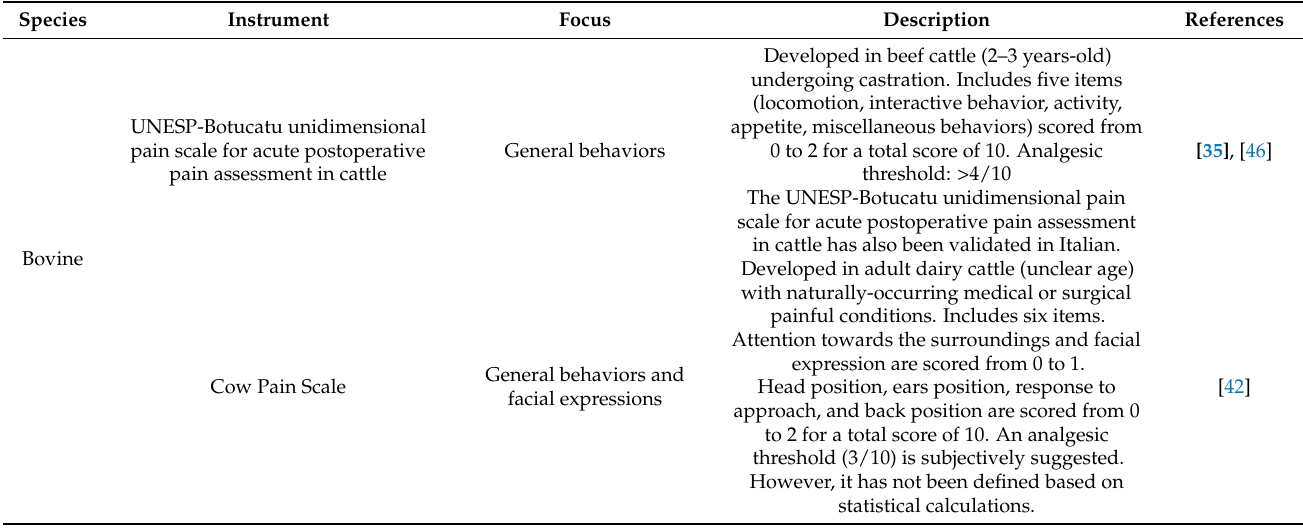
Table 1. Summary of pain assessment composite tools and facial